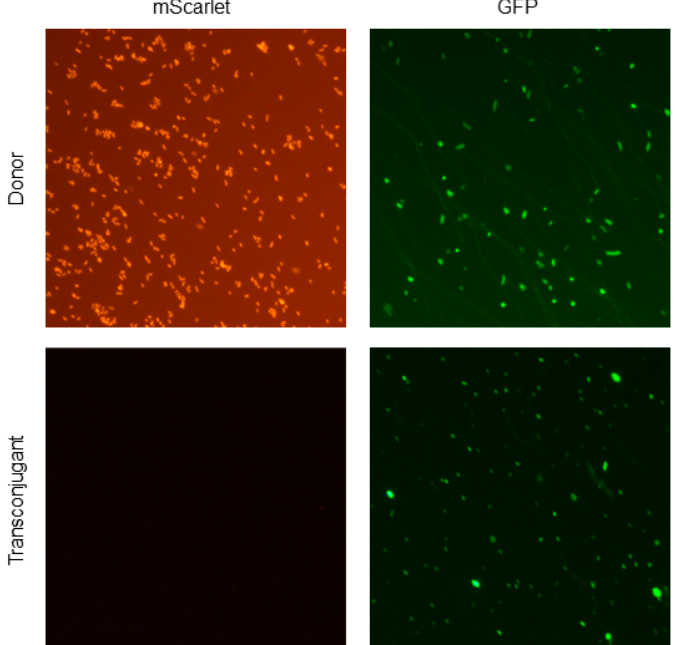
Figure 6. Fluorescent microscopic confirmation of RP4 plasmid transfer from the donor E. coli LM715-1 to transconjugant bacteria. The upper row of micrographs in Figure 6 shows that donor E. coli LM715-1 bacteria express both chromosomal mScarlet and plasmid-encoded GFP. The lower row shows the transconjugant bacteria expressing only plasmid-encoded GFP. All micrographs were taken using a Nikon Eclipse N i -U upright microscope (Nikon, Tokyo, Japan) equipped with GFP and RFP filters at 20× magnification.